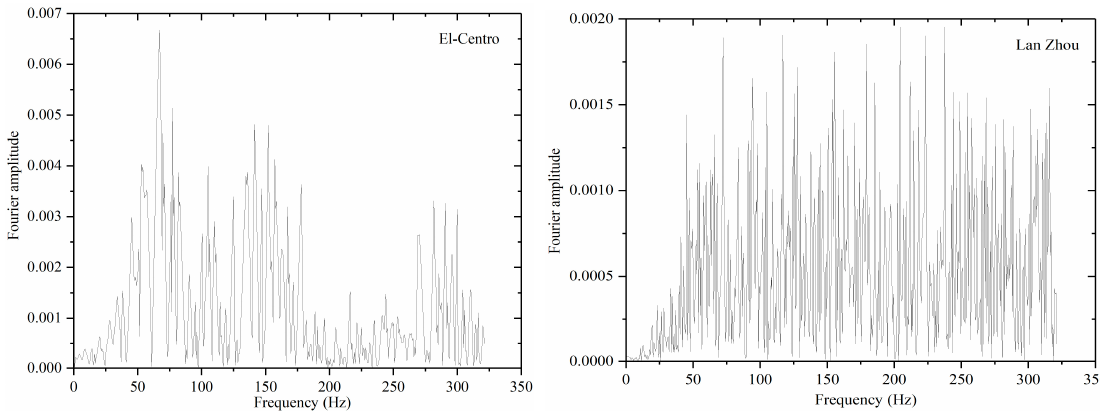
Figure 9. Fourier spectrum of excitations.